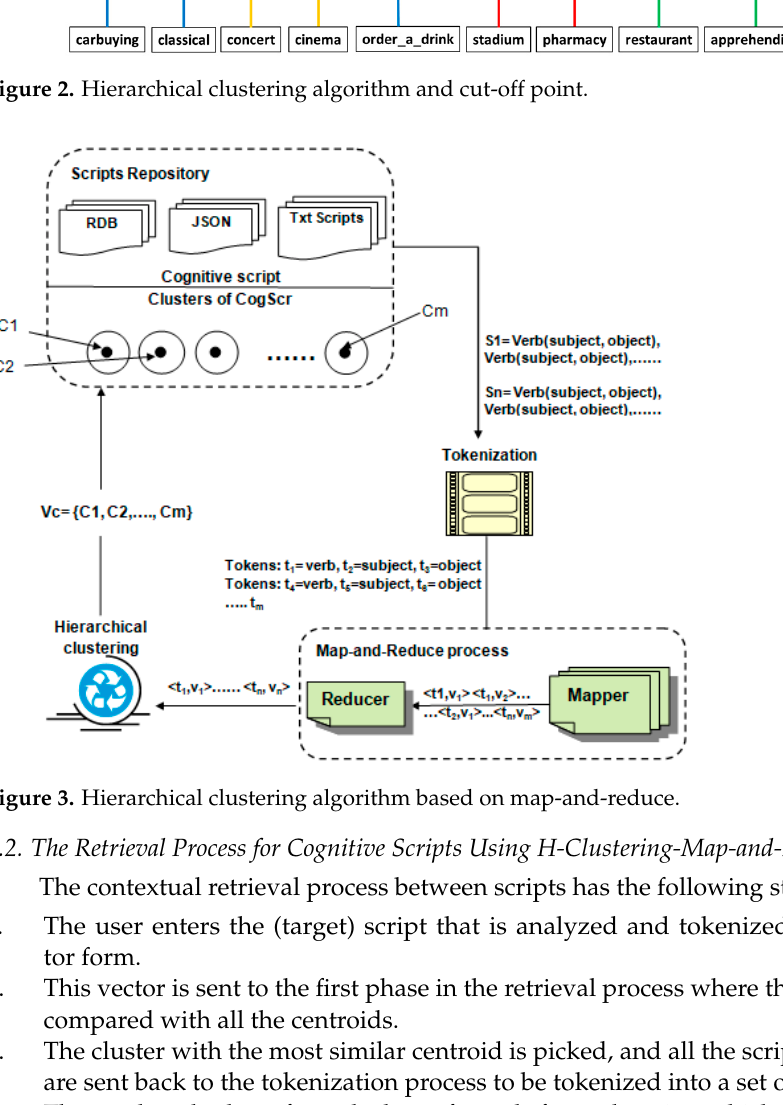
Figure 3 . Hierarchical clustering algorithm based on map-and-reduce .